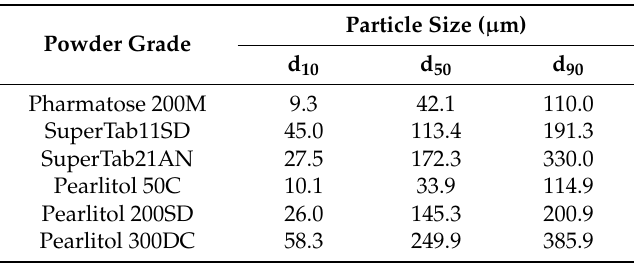
Table 2. Primary particle size of powders used in the